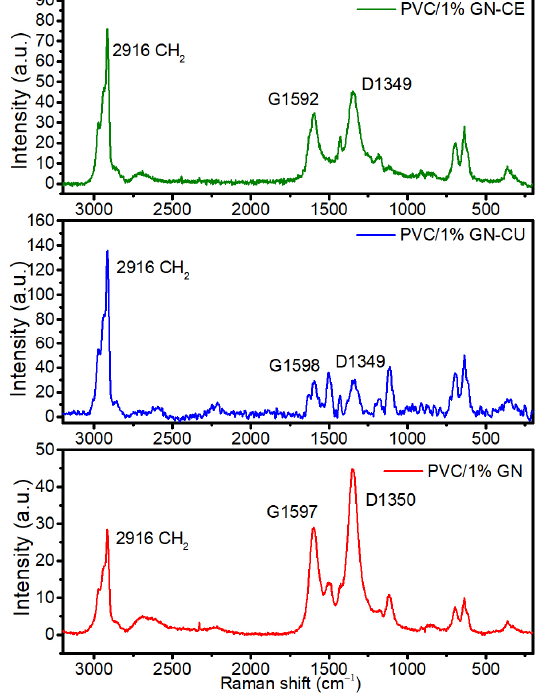
Figure 8. Raman spectra of PVC/1%GN, PVC/1%GN–CU and PVC/1%GN–CE . AFM also investigated the surface structure of the obtained nanocomposites in contact with a surface (the upper side of the surface that was not in contact with glass during THF evaporation, forming a polymer film). AFM allows for the direct evaluation of the dispersion of graphene in the PVC matrix and the determination of roughness [94,96]. Figure 9 shows 2D and 3D images of nanocomposites containing modified and unmodi- fied graphene.